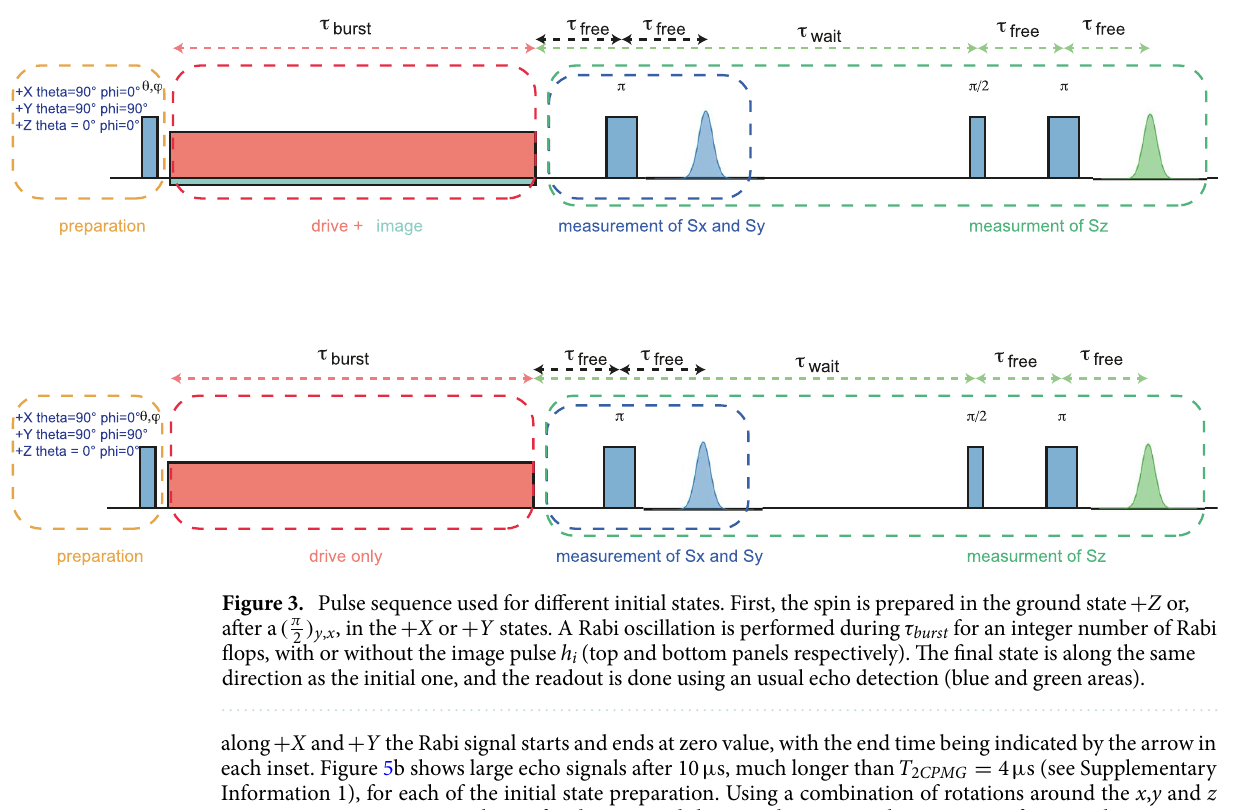
Figure 3. Pulse sequence used for different initial states. First, the spin is prepared in the ground state X or Y states. A Rabi oscillation is performed during τ burst for an integer number of Rabi after a ( π 2 ) y , x , in the + + flops, with or without the image pulse h i (top and bottom panels respectively). The final state is along the same direction as the initial one, and the readout is done using an usual echo detection (blue and green